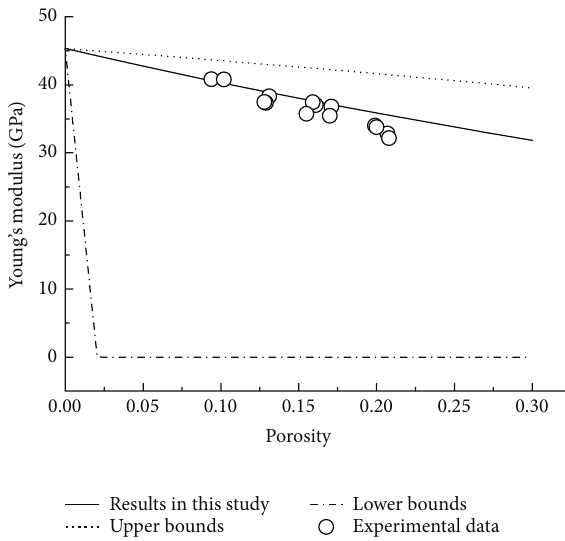
Figure8:Thecomparisonbetweentheresultsobtainedwiththedif- ferent micromechanical models and those obtained experimentally [48] for the static Young modulus of saturated